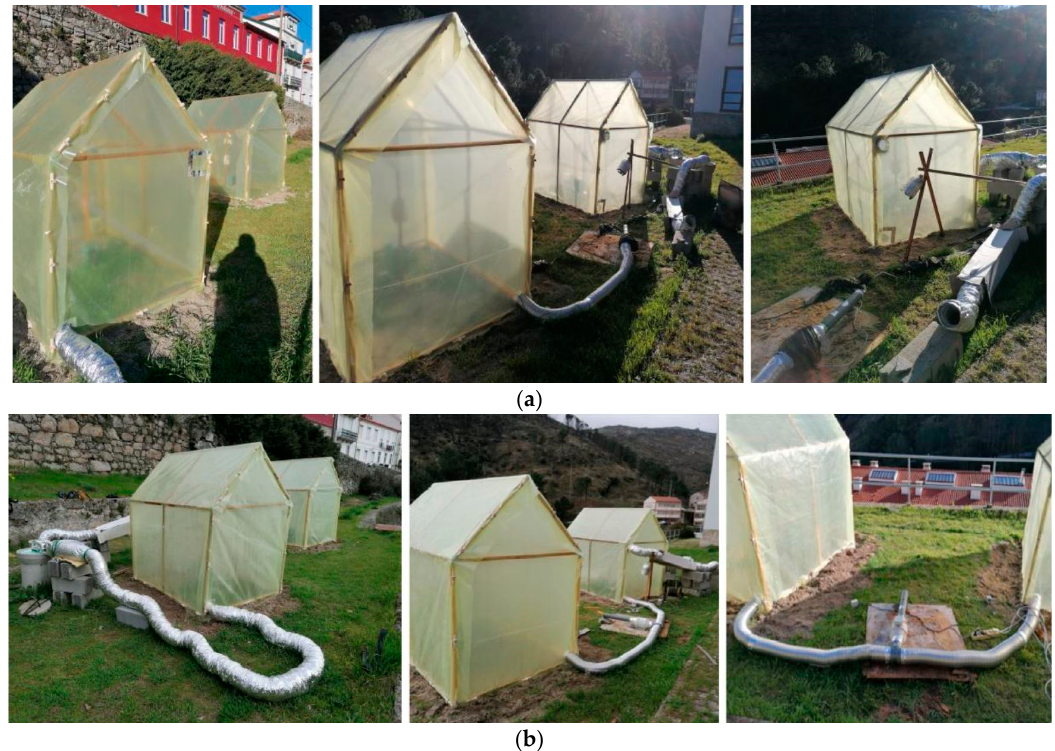
Figure 3. Details of the two scaled-down models. ( a ) Open-loop photographs. ( b ) Closed-loop pho- Figure 3. Detailsofthetwoscaled-downmodels. ( a )Open-loopphotographs. ( b )Closed-loopphotographs. tographs.